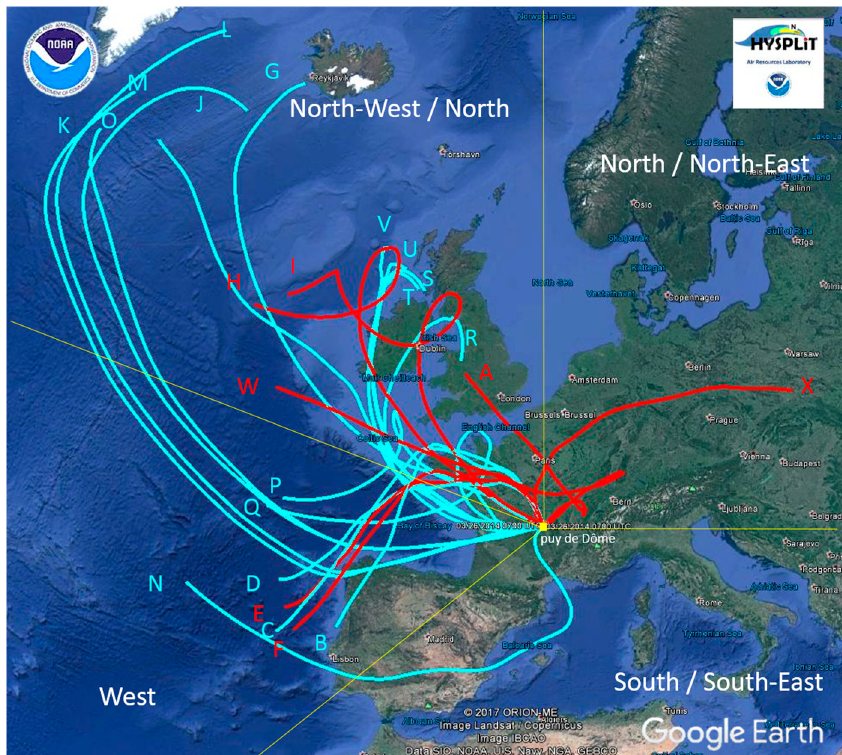
Figure 1. Back-trajectory sectors of air masses reaching the puy de Dôme. Yellow lines depict the four different sectors identified: Air mass origin was calculated by NOAA-HYSPLIT using 72 h back-trajectory and the direction of air mass before arriving at the puy de Dôme mountain is reported in blue for marine samples and in red for continental samples, following the HCA1 (hierarchic cluster analysis) analysis performed on samples analyzed in this work plus samples from Deguillaume et al. [31] (174 observations).